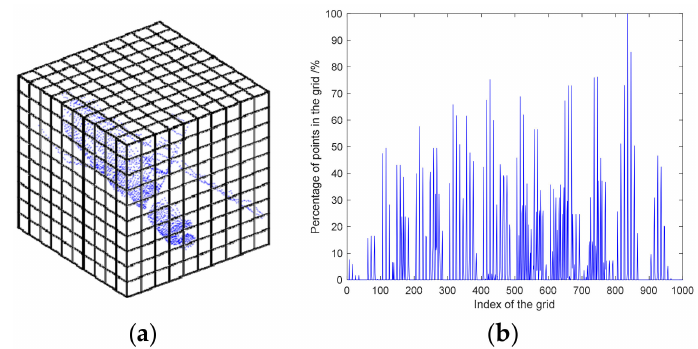
Figure 2. Schematic diagram of point cloud spatial distribution feature extraction: ( a ) Spatial rasterization, and ( b ) spatial distribution features of one